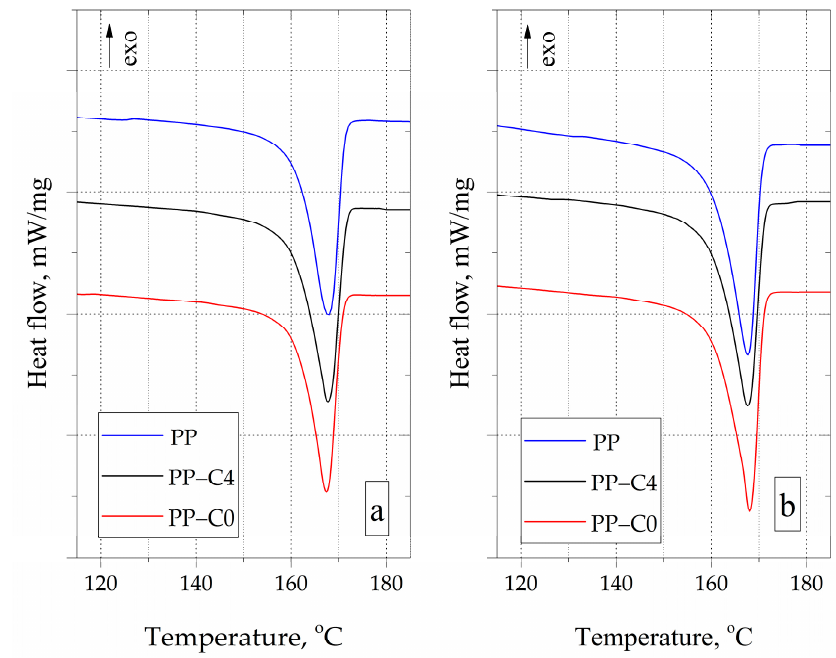
Table 3. Thermal properties of PP